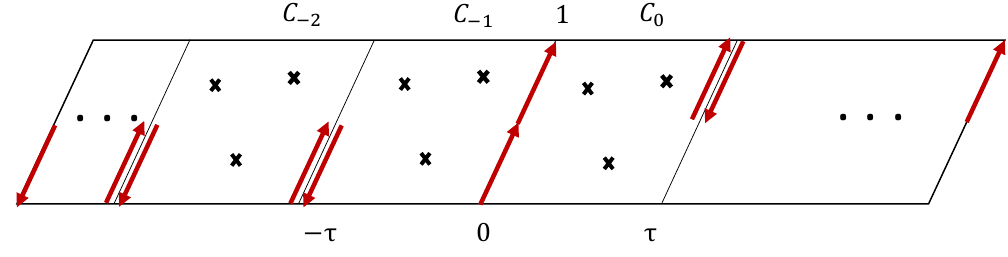
Figure 2 . Decomposition of the boundary integral C (cid:17) the R -charges and of (cid:17) , the contour in the bulk cancel each other and only the unit circle contour a 1 = 0